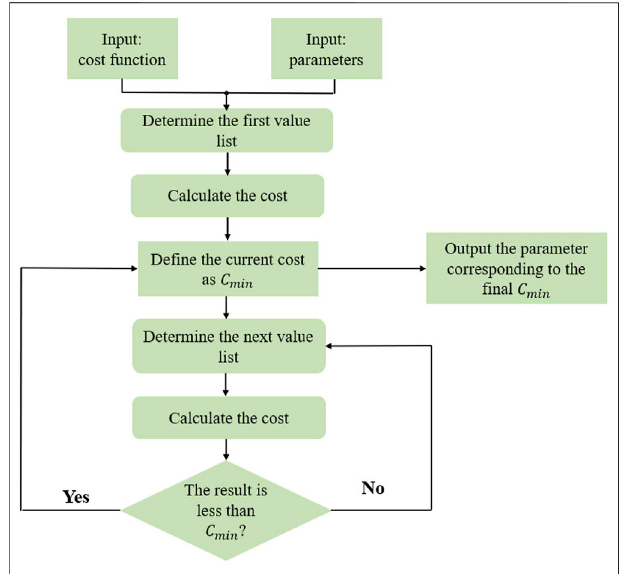
FIGURE 4 | Logic diagram of capacity utilization share control optimization